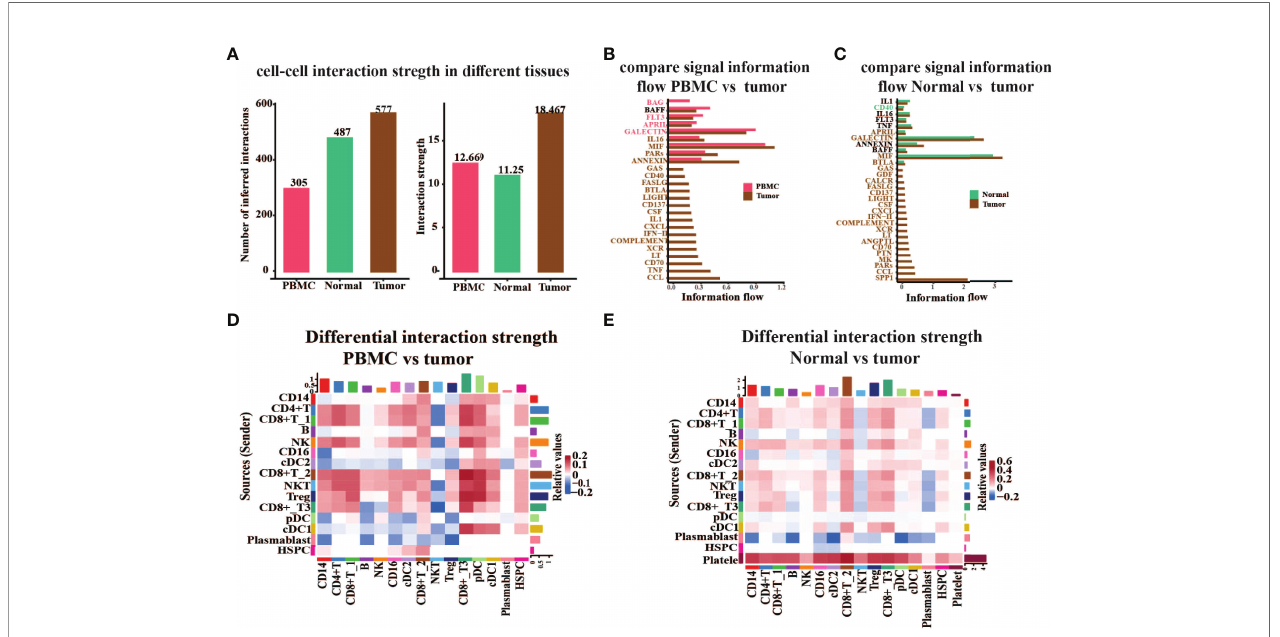
FIGURE 6 | Global analysis cell – cell interaction features in different tissue types. (A) The number or strength of the interaction among all major cell types in peripheral blood (PBMC), tumor-adjacent normal tissue (Normal), and renal tumor tissue (Tumor). (B, C) Comparison of the signal information fl ow in tumor compared to PBMC (B) or normal (C) . (D, E) Heatmap of different interaction strengths in tumor compared to PBMC (D) or Normal (E) . The vertical axis is the cell sending the signal, the horizontal axis is the cell receiving the signal, the shades of color on the heatmap represent the relative signal strength, and the bars on the top and right represent the cumulative intensity on the horizontal and vertical